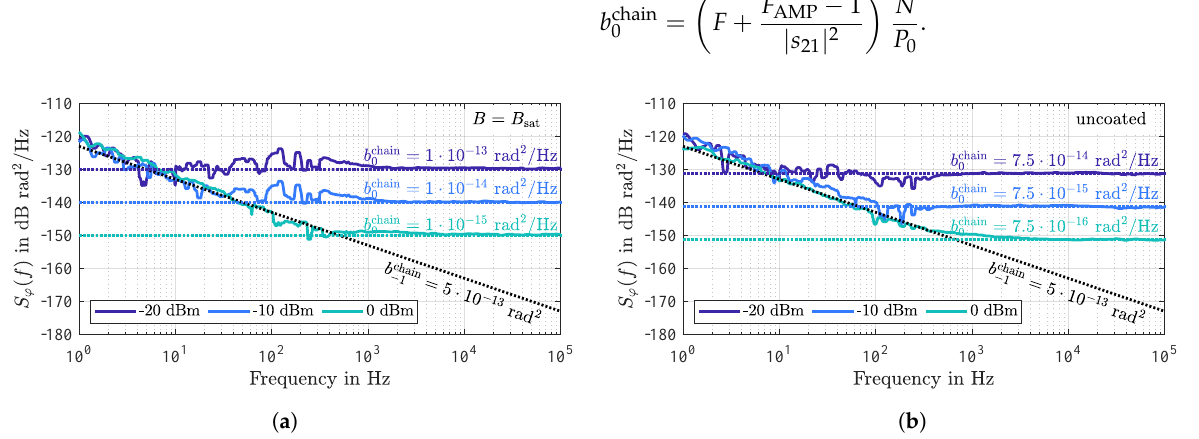
Figure 7. Measured power spectral densities S ϕ ( f ) of the random phase fluctuations ∆ ϕ ( t ) of the magnetostrictively coated sensor in magnetic saturation ( a ) and of an uncoated reference delay line ( b ). Both devices are measured for various input power levels P 0 and with an additional preamplifier. In agreement with Equation (11), the additive white phase noise decreases with P 0 . Equal values for the parametric 1/ f flicker phase noise are observed because both devices are located on the same